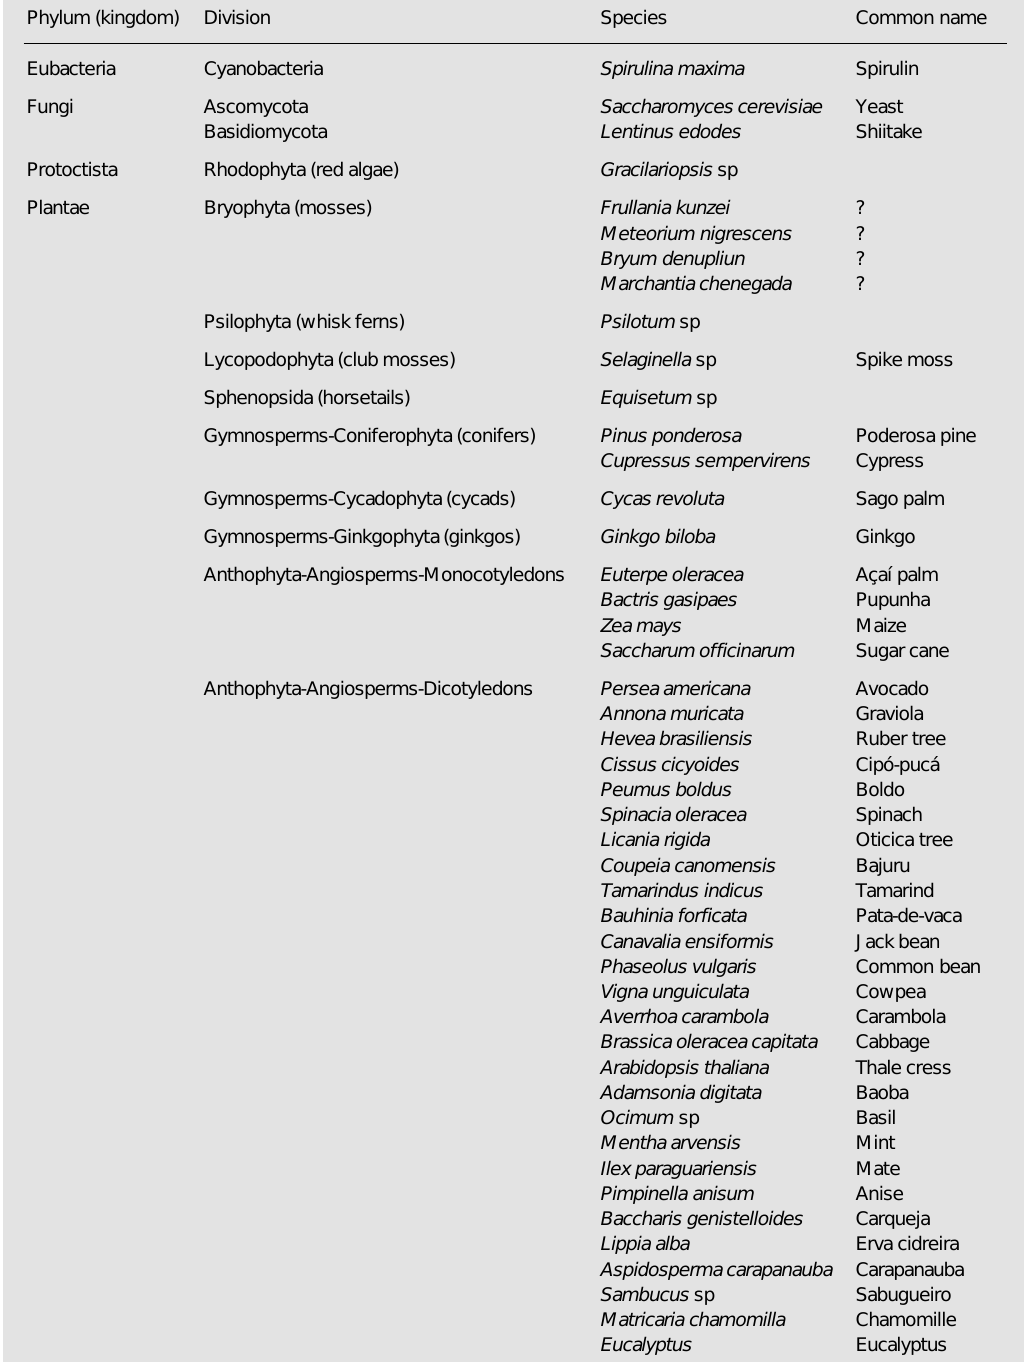
Table 1. List of phyla (green plants, cyanobacterium, red alga, and fungi) and species which tested positive for insulin- like antigens with an antibody to human insulin.